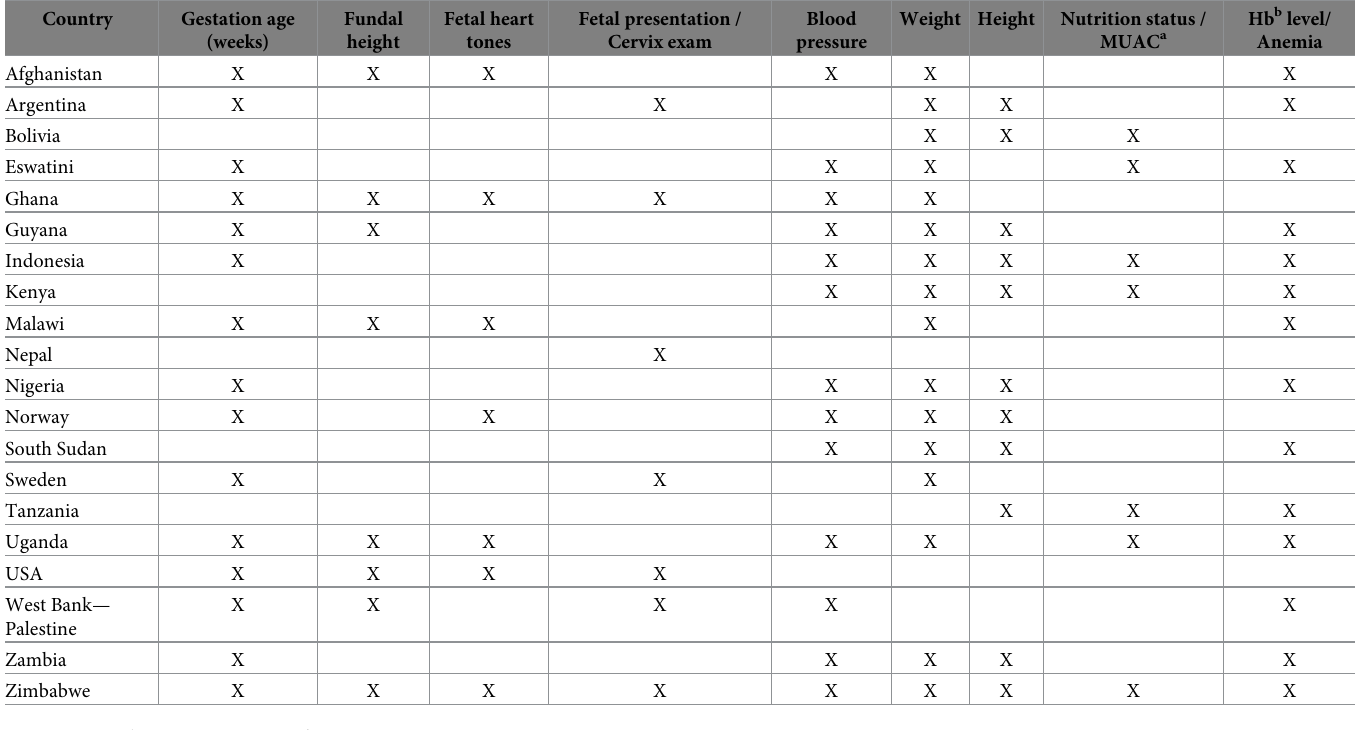
Table 2. Key measurements during antenatal care